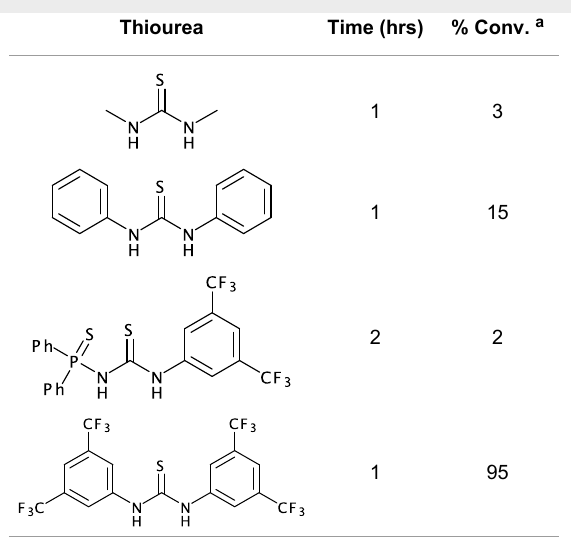
Table 1: Effect of different thiourea on ene reaction.